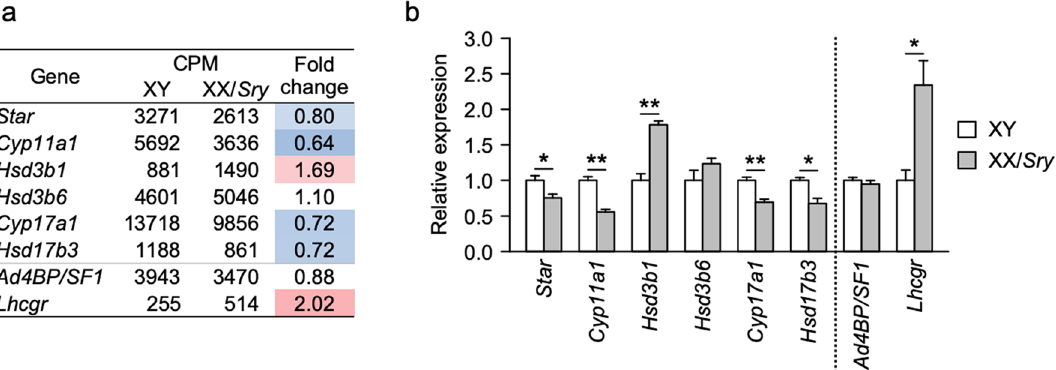
Figure 6. Steroidogenic gene expression is affected in XX/ Sry ALCs. ( a ) Expression of steroidogenic genes as well as Ad4BP/SF-1 and Lhcgr in the XY and XX/ Sry ALC transcriptome datasets. CPMs are the means of biological triplicates. Increased and decreased gene expression in the XX/ Sry ALCs is indicated in red and blue, respectively, with deeper shading for larger differences. ( b ) Expression of the genes shown in ( a ) was validated by qRT-PCR. The data were normalized to Actb and are presented as means ± SEM. Three biologically independent samples (n = 3) were used. * p < 0.05, ** p < 0.01, *** p < 0.001, using Student’s t -test ( b ). R software version 3.4.3 (https ://www.r-proje ct.org) was used to draw the plots in ( b